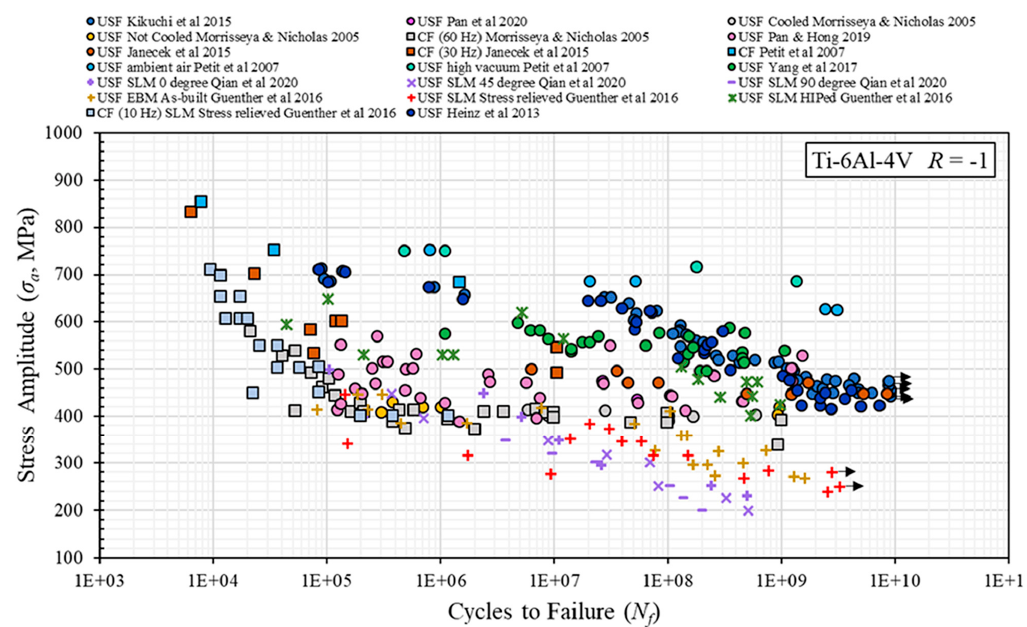
Figure 11. Fatigue data for Ti6Al4V across numerous investigations, generated by conventional and ultrasonic fatigue testing at R = − 1 [62–71].